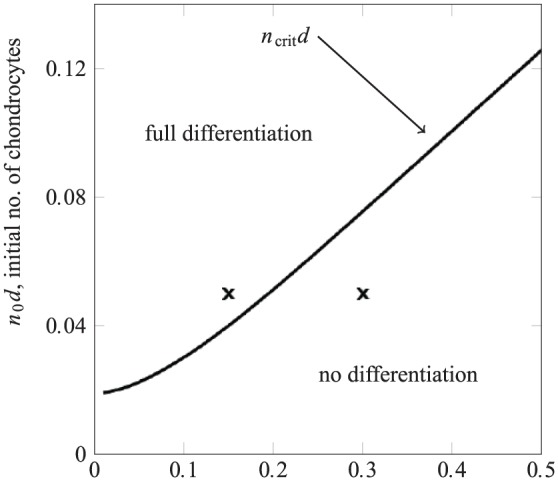
Dependence of the long term outcome on upper layer depth d and the initial number of chondrocytes seeded into the upper layer n0d (per cross-sectional area). The solid line divides the parameters space into regions where either no differentiation occurs or the initial MSC population is completely differentiated. The crosses indicate two seeding strategies that use the same number of initial chondrocytes with only the case represented by the leftmost cross leading to full differentiation.